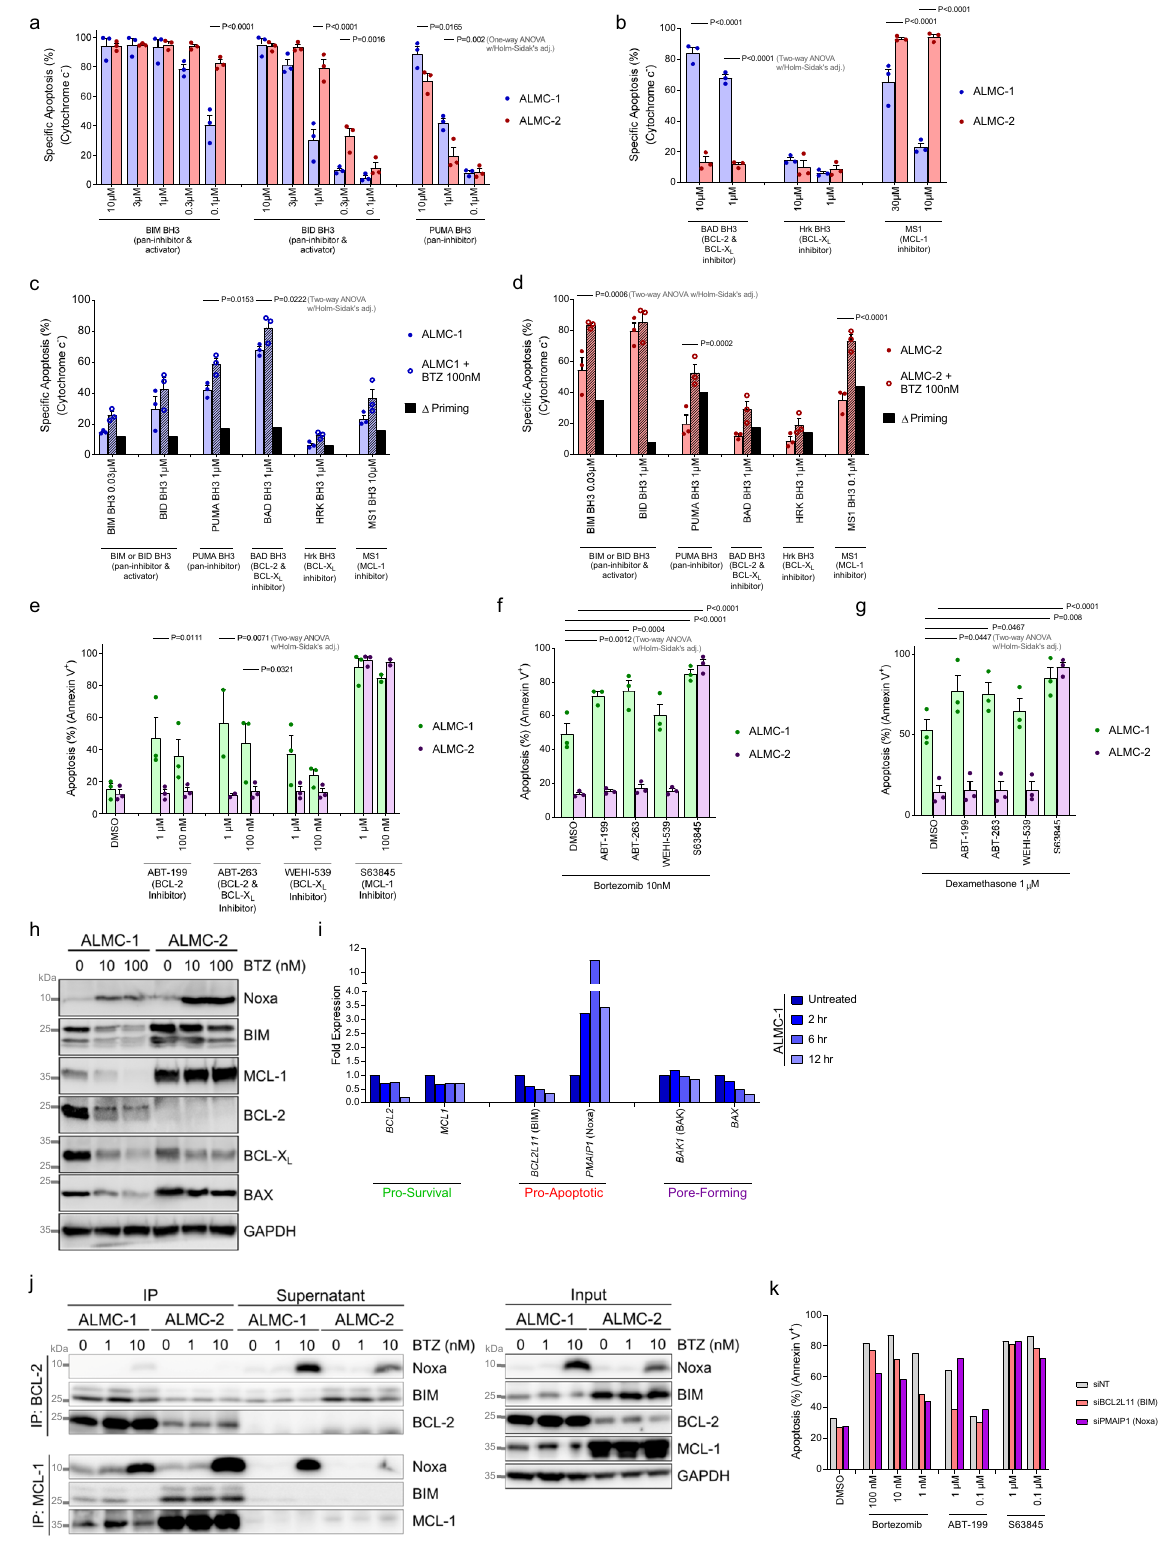
(Fig. 6a). In untreated cells, we observed protein levels of BCL-2 family members that were in agreement with our immunoblotting results: BCL-2 and BCL-X L levels were higher in ALMC-1 whereas MCL-1 expression was four-fold higher in the relapsed MM cell line (Fig. 6b). Abundance of pro-apoptotic and pore-forming proteins was largely similar between the two cell lines, yet we did note an increase in BAK